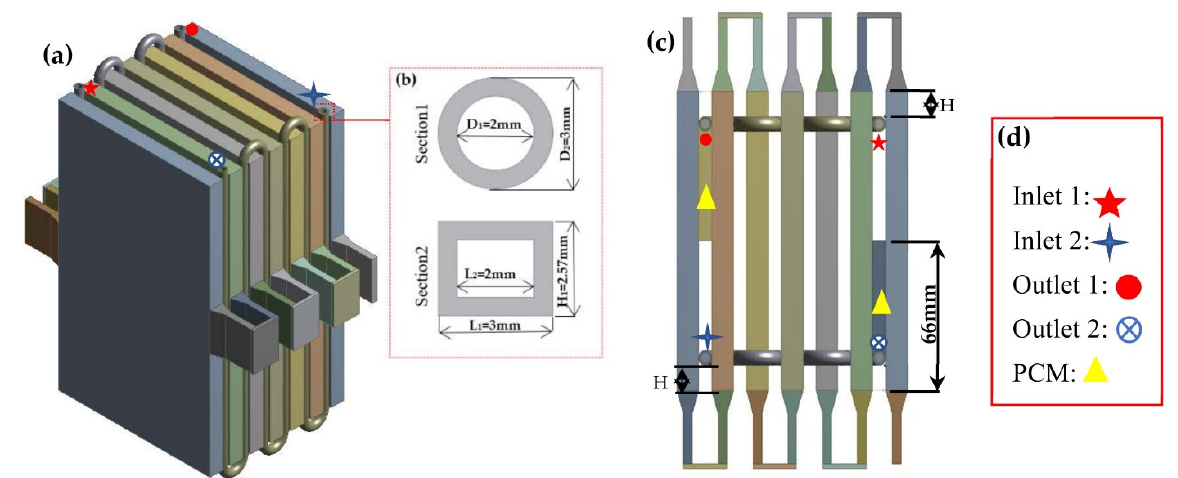
Figure 2. Schematic of liquid cooling: ( a ) layout of pipes of 1P7S battery pack; ( b ) different sections for the round and square pipes; ( c ) movement of pipe position (top view); ( d ) symbols for coolant inlet and outlet.